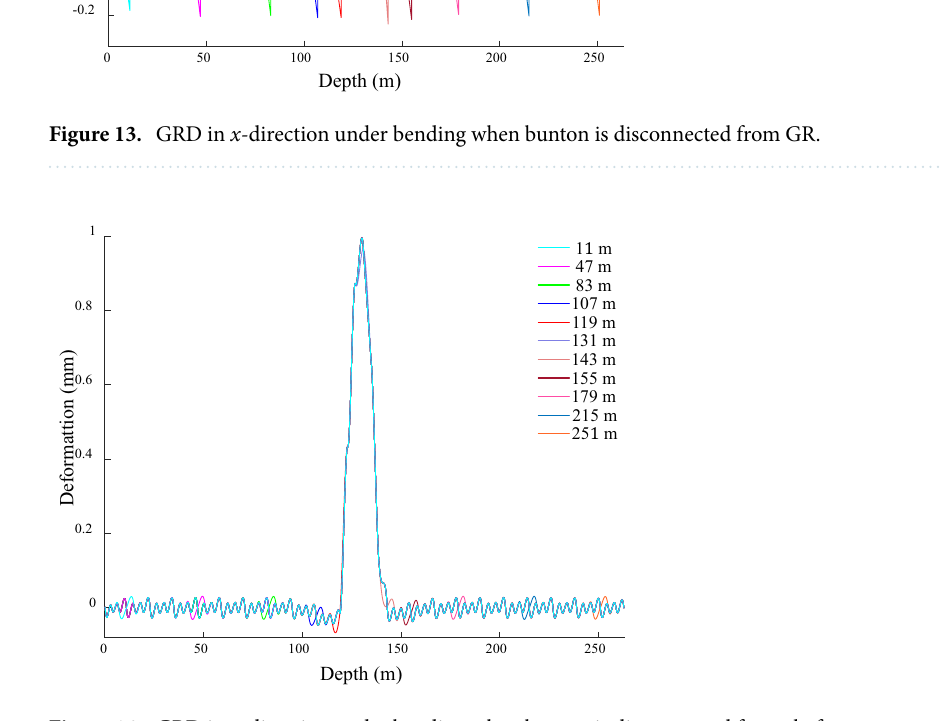
Figure 14. GRD in x -direction under bending when bunton is disconnected from